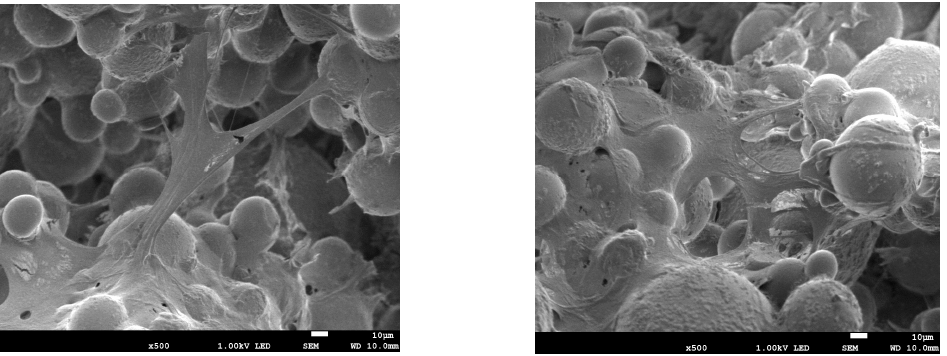
Figure 9. MC3T3-E1 cells adhesion to the surface of bone cement coatings after 7 days (the presented pictures are representative for all types of BCs).